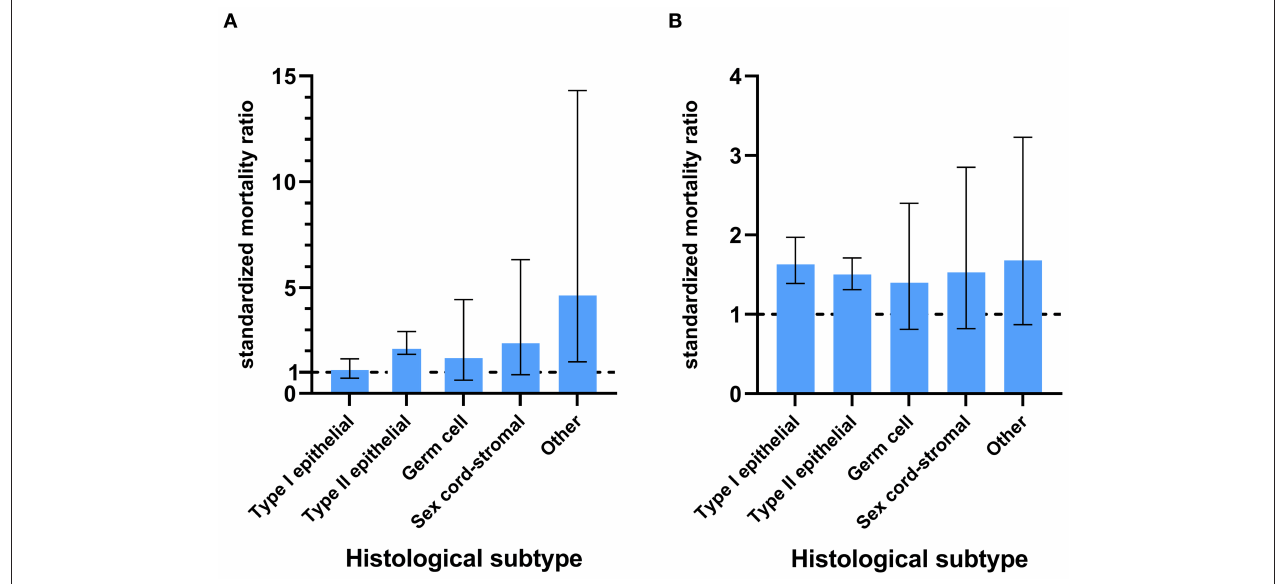
FIGURE 4 | The SMRs with 95% CIs for patients with different subtypes of ovarian cancer. The lower limit of the CI exceeding 1 means that the patients had a higher risk of suicide (A) or accidental death (B) compared with the general population.